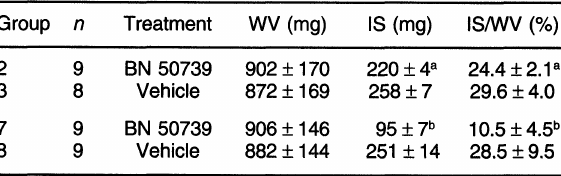
Table 3. Effects of BN 50739 on infarct size in rats subjected to coronary artery ligation and